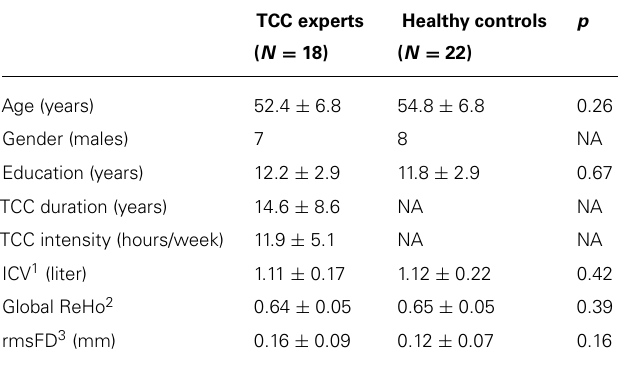
Table 1 | Participant